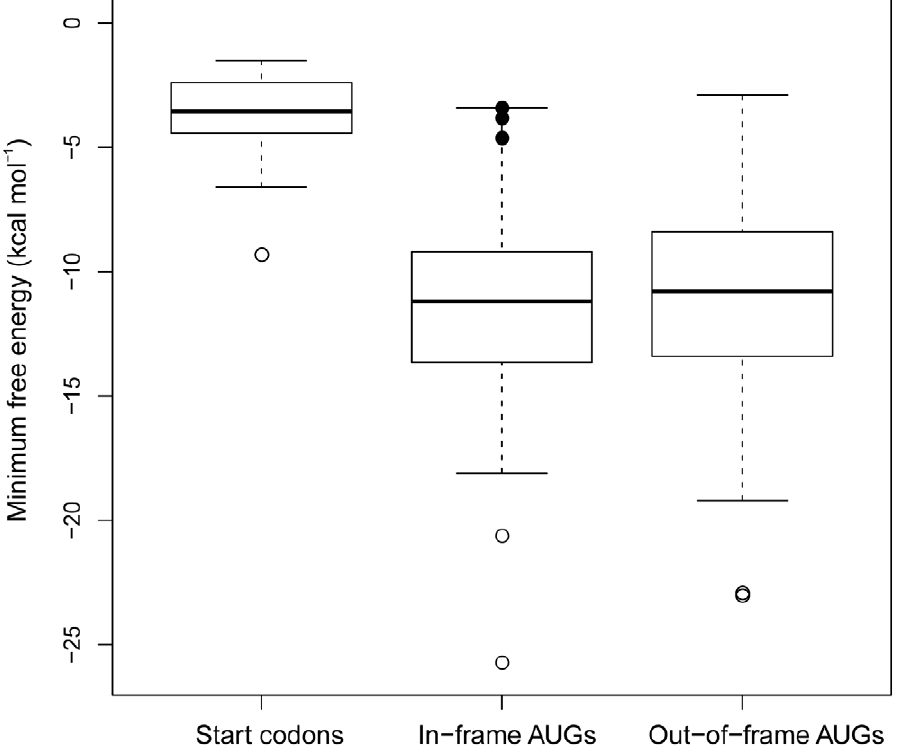
Figure 5. Comparison of the minimum free energy (MFE) values of start codons, in-frame AUG codons, and out-of-frame AUG triplets in the Escherichiacoli genome. The middle line in the box is the median, the next two are the 1 st and 3 rd quartiles, the whiskers extend to 1.5 times the interquartile range of the box. Outliers are indicated by open circles. The outlier in the start codon group is the MFE value for the start codon of trmD (see text for details). Three in-frame AUGs (filled black circles) of murC , metG and trmD , respectively, were singled out for their close proximity and MFE to the start codon. Based on the low amount of structure around them, these AUGs are candidates for alternative translation initiation